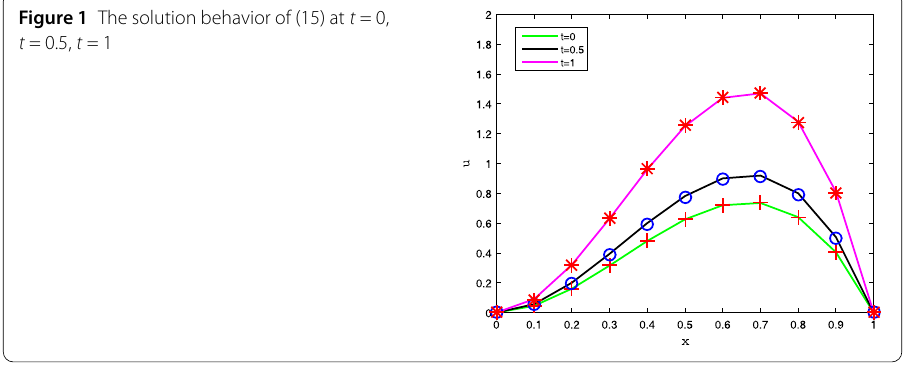
Figure 2 Three-dimensional numerical solution (left) and the exact solution (right) of